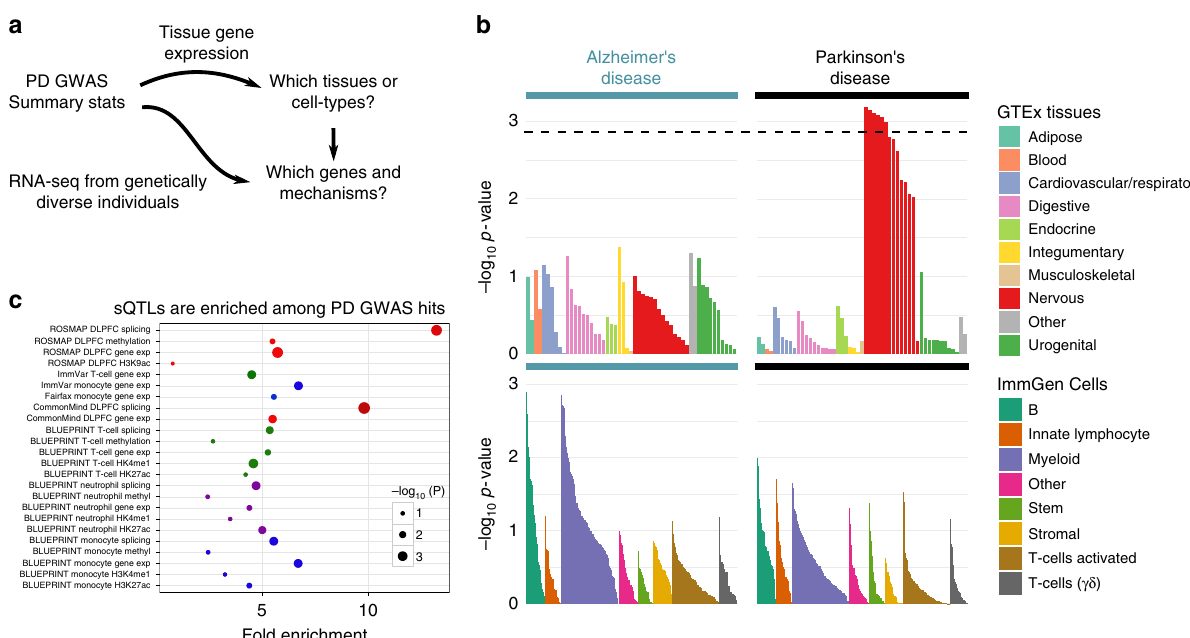
Fig. 1 Enrichment of tissues and cell types in Parkinson ’ s disease (PD). a Study design. Using PD genome-wide association studies (GWAS) summary statistics and gene expression datasets to: (1) identify tissues and cell types enriched in PD GWAS signal, and (2) to identify genes and mechanisms through which PD-associated loci act to affect disease risk. b Linkage disequilibrium (LD) score regression in speci fi cally expressed genes (LD-SEG) analysis applied to late-onset AD (17,008 cases and 37,154 controls) 26 and PD (13,708 cases and 95,282 controls) 31 GWAS summary statistics. Top panel: Regions of the genome with speci fi c expression in central nervous system (CNS) tissues are highly enriched for PD GWAS signal, among 53 tissues obtained from the Genotype-Tissue expression project (GTEx). Shown in red bars are CNS tissues. Six CNS tissues (amygdala, substantia nigra, anterior cingulate cortex, frontal cortex, hypothalamus, and cervical (C1) spinal cord) are signi fi cant at 5% false discovery rate (FDR) (dotted line). Bottom panel: LD-SEG analysis using immune cells from the ImmGen Consortium. c Enrichment of gene expression, splicing, methylation and chromatin quantitative loci (QTL) in PD GWAS ( p value < 10 – 5 ) across tissues and cell types with GARFIELD. GARFIELD leverages GWAS signal with functional annotations to fi nd features such as QTL annotations relevant to a phenotype of interest. All molecular QTLs were enriched in PD-associated variants, and that brain splicing QTLs (sQTLs) showed the strongest enrichment in PD-associated variants among all molecular